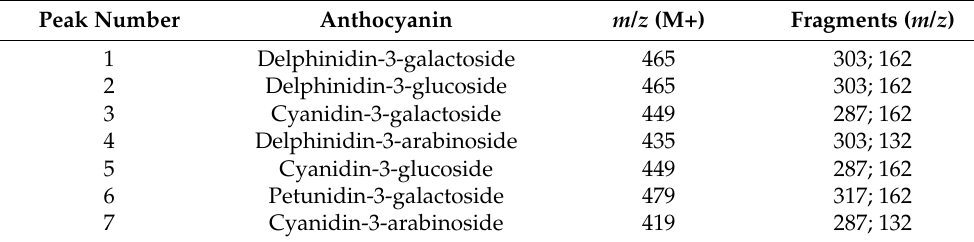
Figure 1. Peaks identified in the tested extracts chromatogram. Table 1. Compositional characterization of the blueberry extract by HPLC-MS. Peak